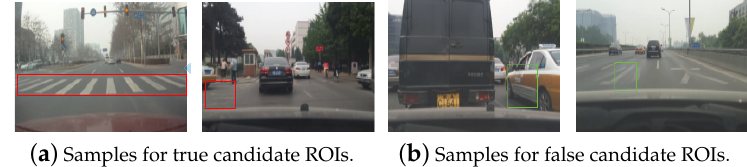
Figure 7. Samples for the true candidate ROIs and false candidate